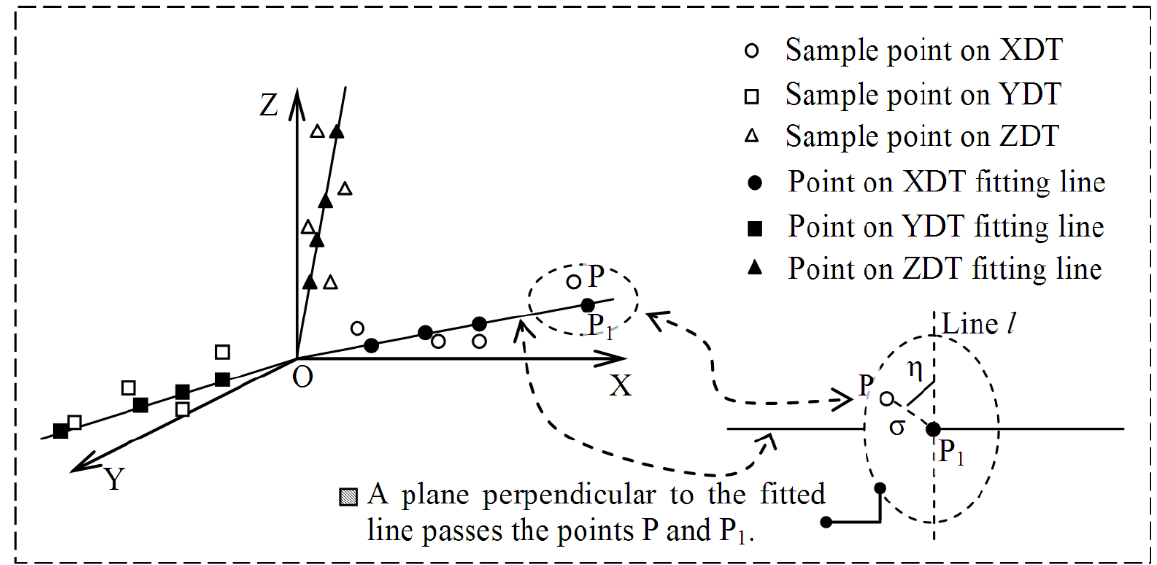
Figure 8. The definition of the error parameters of the fitted spatial line, where XDT = X-direction motion trajectory, YDT = Y-direction motion trajectory, ZDT = Z-direction motion trajectory. Two parameters, σ and η , are used. The parameter σ represents the distance between a point P and a fitted line, and point P 1 is one of the fitted points corresponding to point P. The parameter η is used to describe the azimuth of a sample point, which is the intersection angle between the lines PP 1 and l . The line l is located in the plane passing the points P 1 and P, and perpendicular to the fitted line OP 1 .